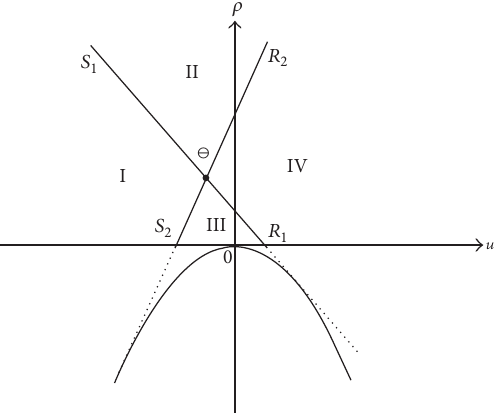
Figure 1: For the given left state (𝑢 − , 𝜌 − ) , the half-upper (𝑢, 𝜌) phase plane is shown for the Leroux system (1).